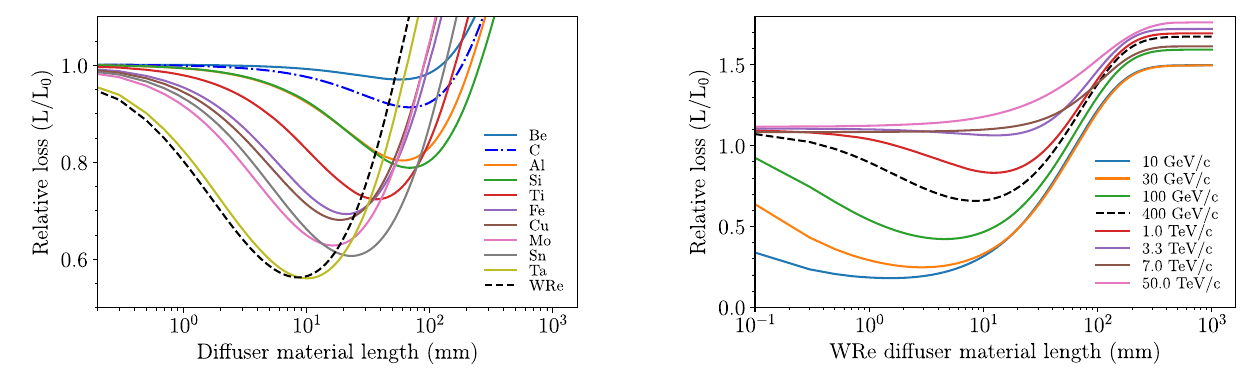
FIG. 3. Analytical calculation of the relative total loss for different diffuser lengths and materials, for 0.25 mm diffuser width, 0.2 mm ES width, 3.8° phase advance, and 400 GeV =c protons.